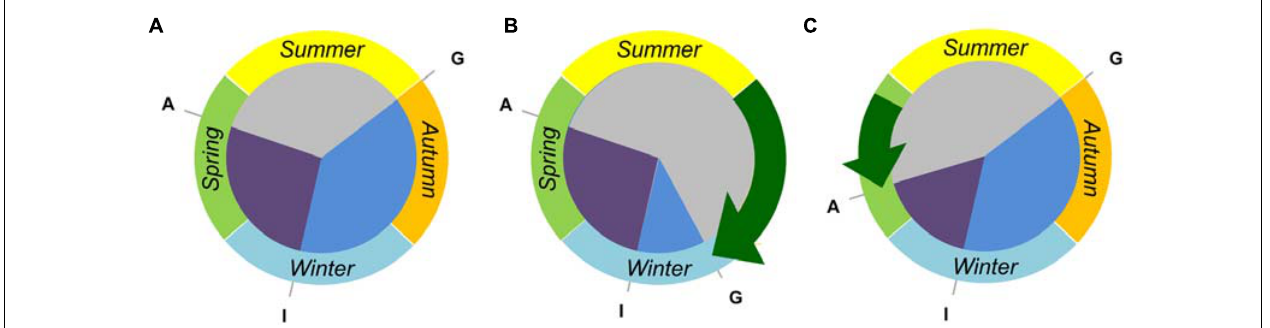
FIGURE 3 |Tailoring the crop life cycle to fit different environments by modifying the duration of discrete developmental phases. (A) A vernalization responsive and daylength sensitive cereal cultivar can be sown and germinate “G” in early autumn but will remain vegetative until late winter, when inflorescence initiation occurs “I”. Anthesis “A” will occur during spring, at a date determined by the photoperiod